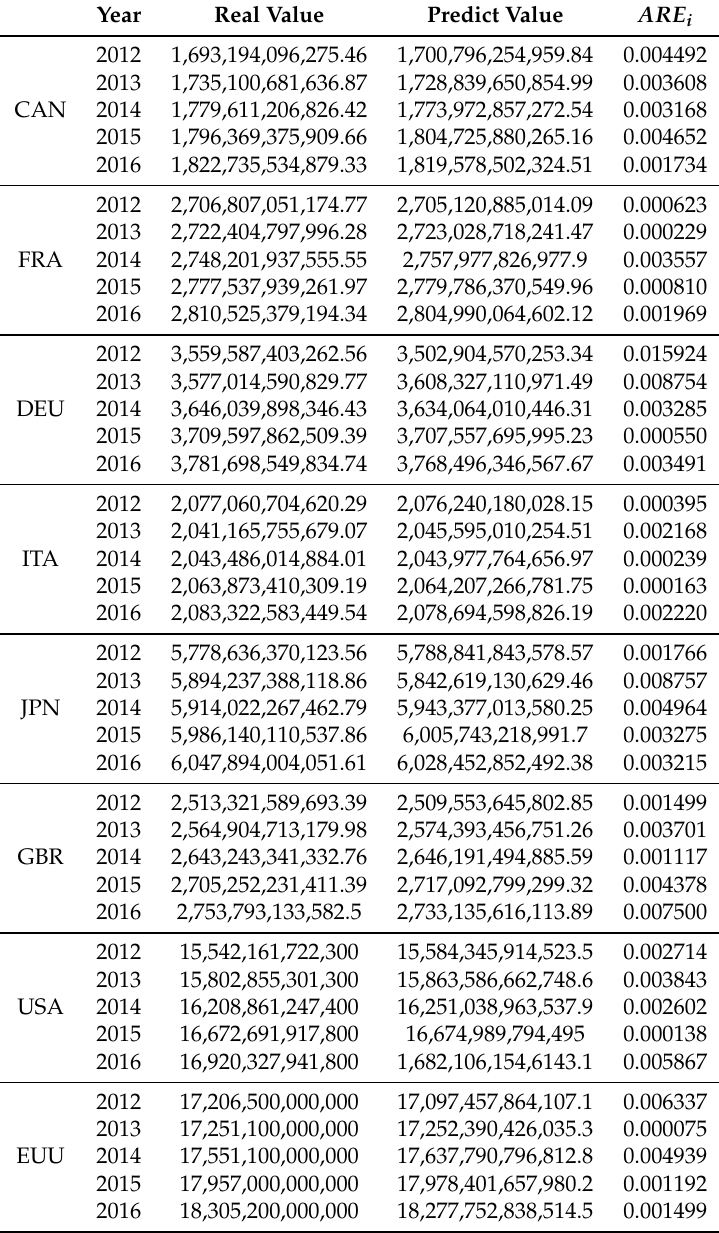
Table 6. Neural network model for G7 countries, GDP data from